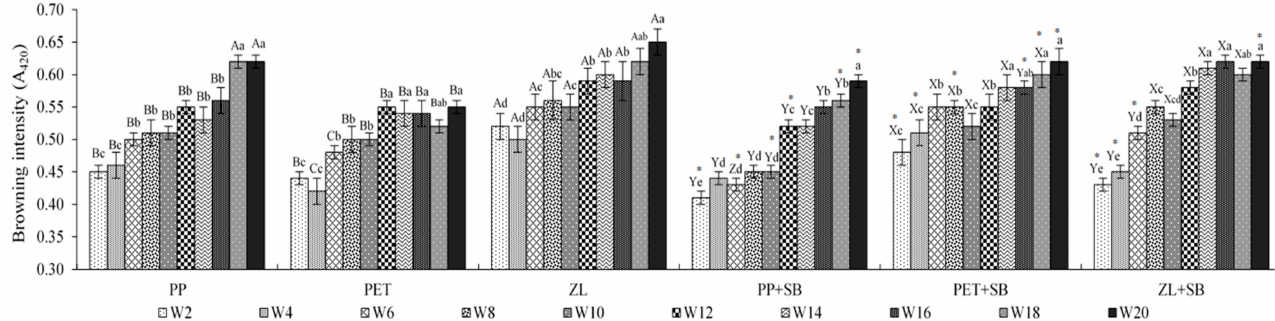
Figure 1. Change in browning intensity (A 420 ) of dried chili fish paste during storage in various packaging at room temperature. Different uppercase letters indicate significant differences ( p < 0.05) due to packaging material at the same period of storage time (without 0.1% SB: A,B,C; with 0.1% SB: X,Y,Z). Significant differences between with/without added 0.1% SB in samples stored in the same packaging material are indicated by an asterisk (*) on the added preservative samples ( p < 0.05). Different lowercase letters indicate significant differences ( p < 0.05) due to storage